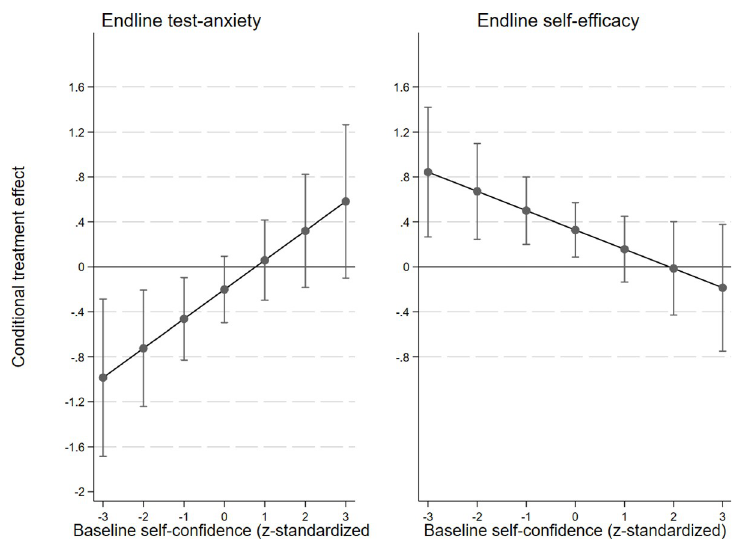
Fig 7. The explored conditional heterogeneous treatment effect (y-axis) on students’ endline test anxiety (left panel) and endline self-efficacy (right panel), based on students’ baseline self-confidence (x-axis). The left panel: corresponds to Model 10 in Table 5, N of observations = 2,014; N of respondents = 1,590. The right panel: corresponds to Model 10 in Table 6, N of observations = 2,016; N of respondents =